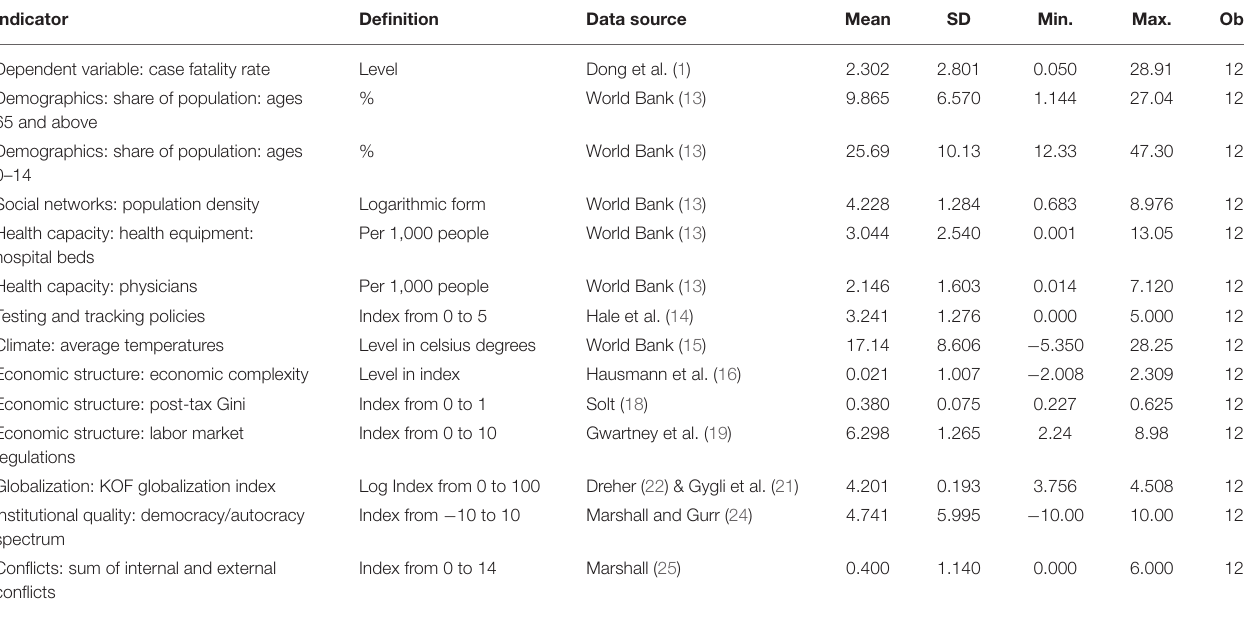
TABLE 1 | Descriptive